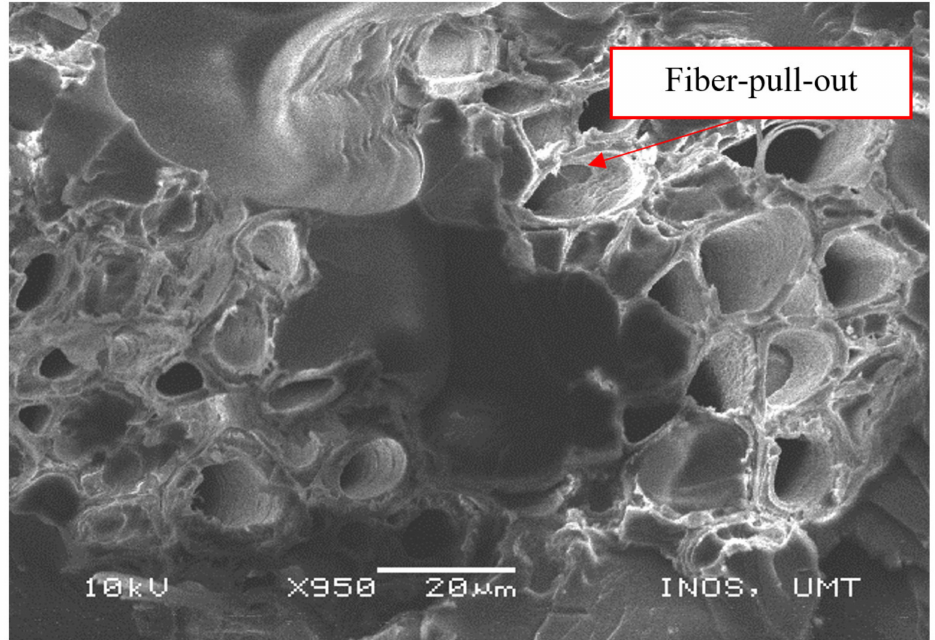
Figure 12. Fiber pull-outs in the epoxy/PET/KF-50